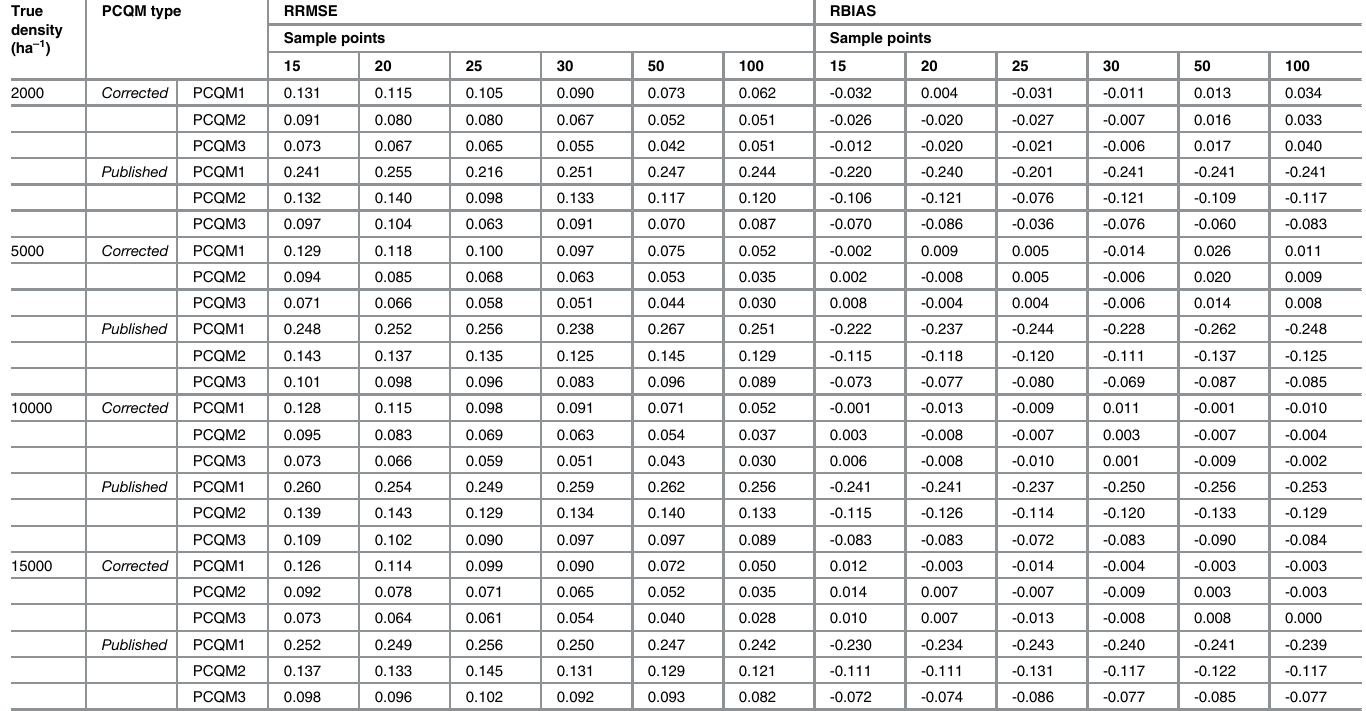
Table 3. The relative root mean square error (RRMSE) and relative bias (RBIAS) with varying true density and “ random ” spatial pattern. PCQM type True density (ha – 1 )